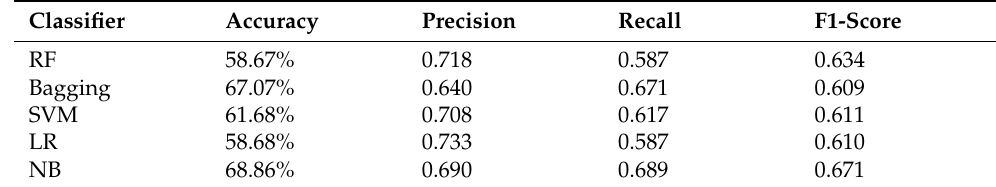
Table 11. Experiments with ML models and TF-IDF on original